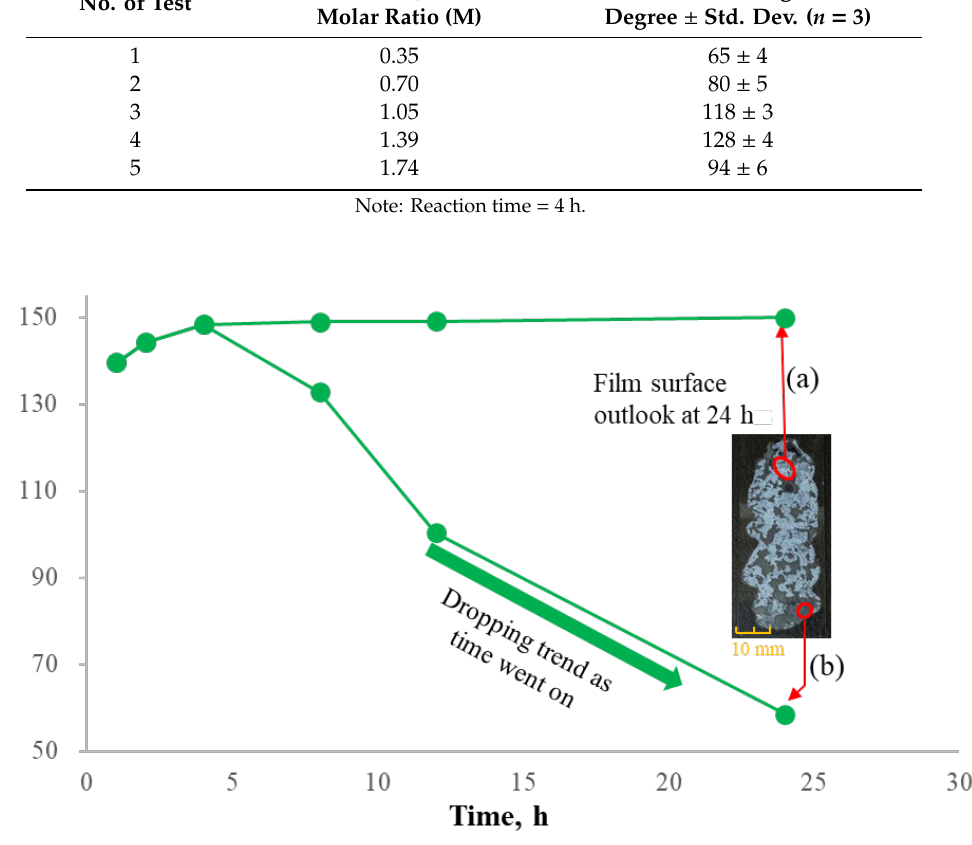
Table 2. Static water CAs of the hydrophobic silica film at various molar ratios (M) of iso- butyltrimethoxysilane (BTMS)/tetraethoxysilane (TEOS). Molar Ratio (M) Iso-BTMS / TEOS No. of Test